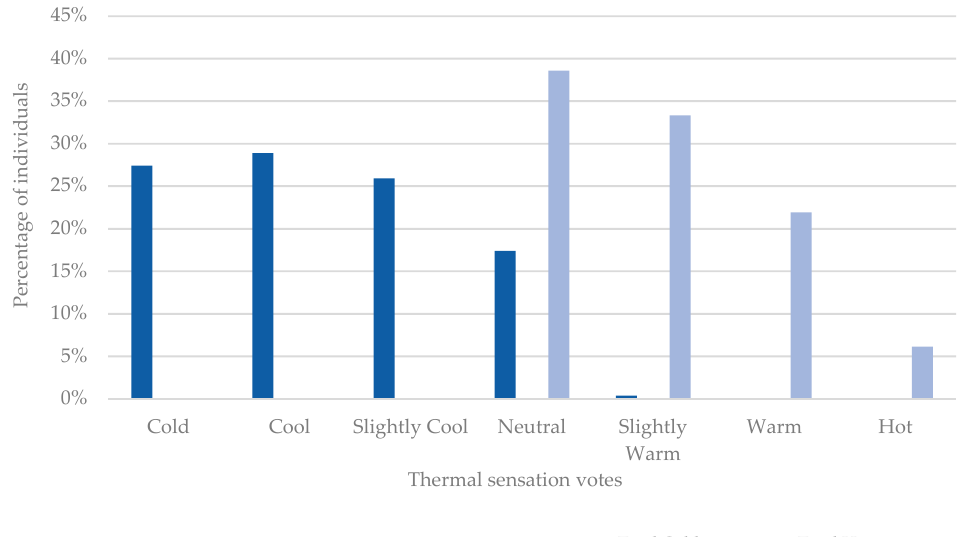
Figure 3. Percentages of thermal sensation votes for all individuals during cold and hot seasons separately. The highest TSV percentage was neutral (38.8%) in the hot season and the highest TSV percentage was cool (28.8%) in the cold season.